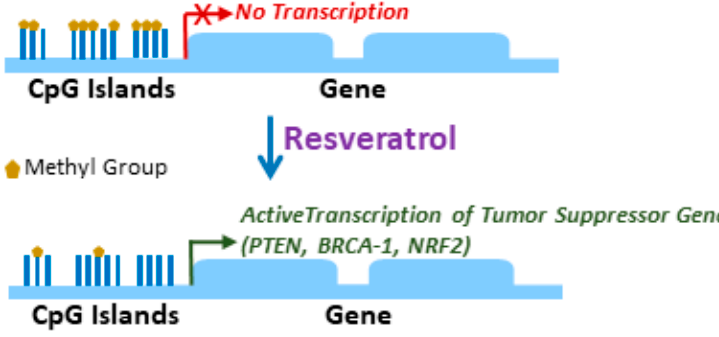
Figure 2. Activation of tumor suppressor genes by resveratrol through promoter DNA hypomethylation. The CpG islands in the DNA promoter regions of the tumor suppressor genes are hypermethylated resulting in their silencing. De-methylation of these CpG islands by resveratrol results in the activation of transcription and the eventual expression of tumor suppressor genes such as the phosphatase and tensin homologue (PTEN), BRCA-1 and nuclear factor erythroid 2-related factor 2 (NRF2).